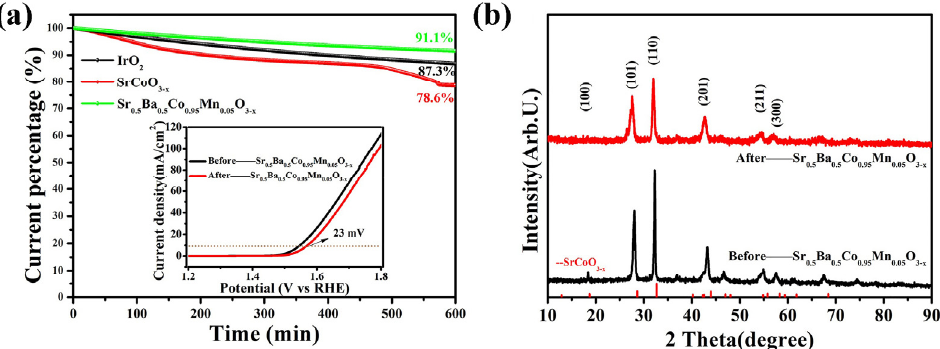
Figure 9. ( a ) Chronoamperometry test of different catalysts, ( b ) XRD comparison chart of Sr 0.5 Ba 0.5 Co 0.95 Mn 0.05 O 3 − x before and after 10 h durability test. In summary, perovskite oxide Sr 0.5 Ba 0.5 Co 0.95 Mn 0.05 O 3 − x was obtained by a simple co-